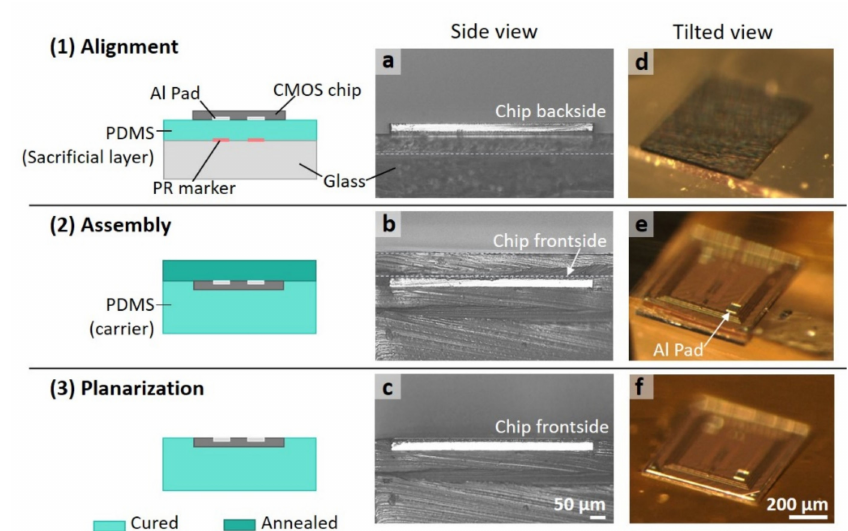
Figure 2. Summary of the alignment, assembly, and planarization processes of a sub-mm sized CMOS chip (left column shows steps ( 1 )–( 3 )), next to microscope optical images in side view ( a – c ) and tilted view ( d – f ) for each step in the 2D planarization process, here using a thinned CMOS chip (650 µ m × 650 µ m × 30 µ m): Step ( 1 ) The chip facing down lands on the spin-coated PDMS film (65 µ m thickness) aligned with its corresponding photoresist (PR) marker. Step ( 2 ) The chip is sandwiched between two PDMS layers (after annealing). Step ( 3 ) The final planarized chip / PDMS assembly is completed after the top PDMS layer is peeled o ff from the contacting chip / PDMS surface. Note the two small square Al-contact pads on the chip discussed below and in text.